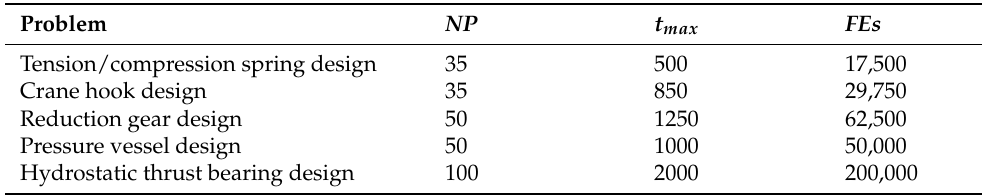
Table 2. The number of function evaluations FEs , maximum iteration number t max and the population size ( NP ) for each design optimisation